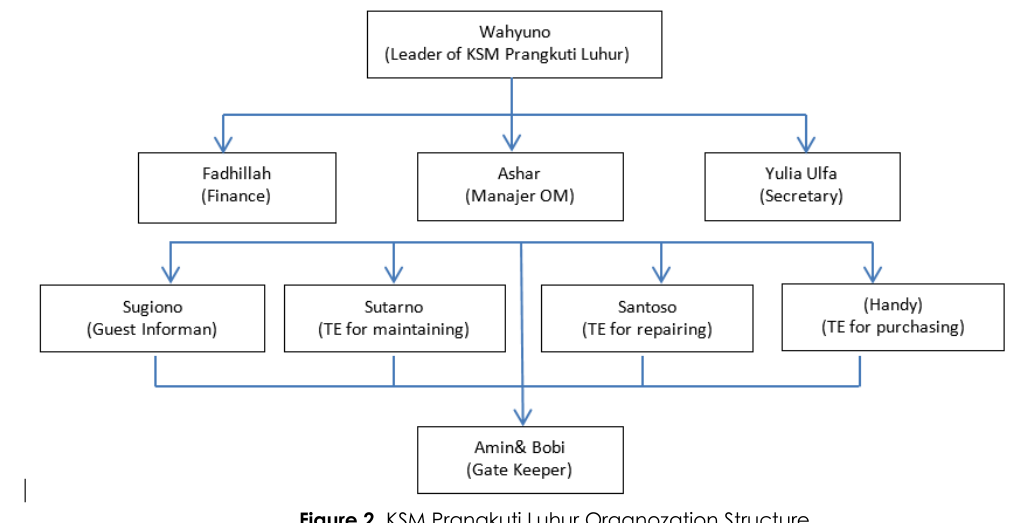
Figure 2. KSM Prangkuti Luhur Organozation Structure Source: research informant 2017